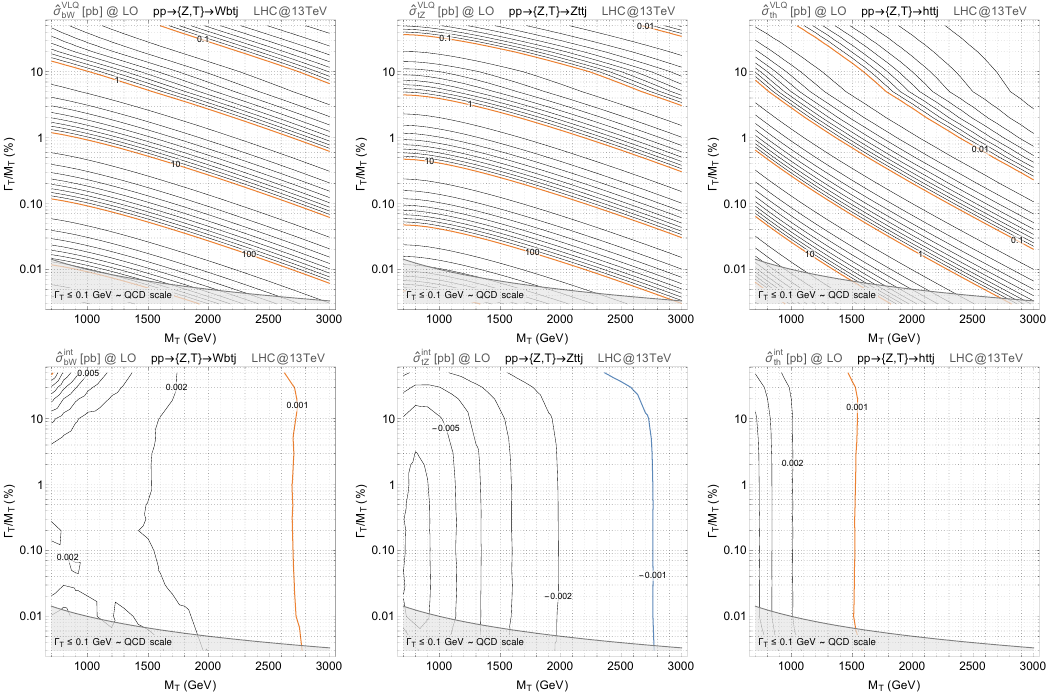
Figure 26 . Values of the ˆ σ VLQ (top row) and ˆ σ int (bottom row) bare cross sections, in pb, for the pp → Wbtj (left), Zttj (centre) and Httj (right) processes. We consider 13 TeV LHC proton- proton collisions and present the results in the ( M